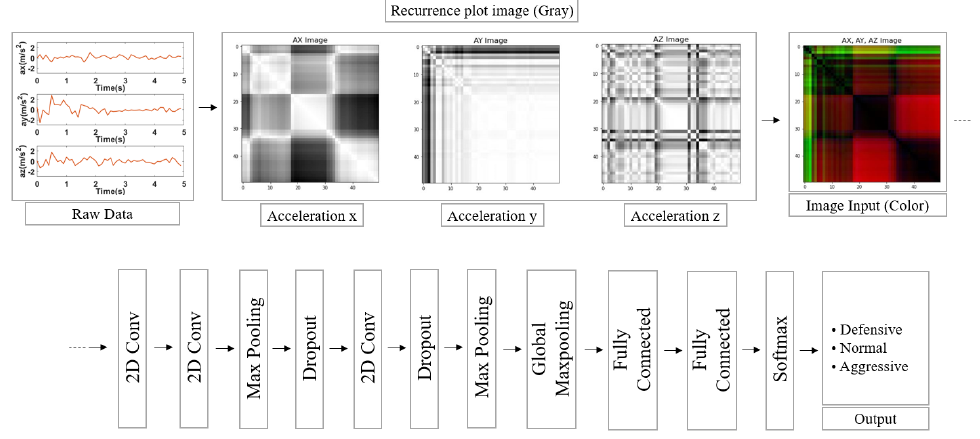
Figure 4. 2-Dimensional Convolution Neural Network (2D-CNN) structure [34].